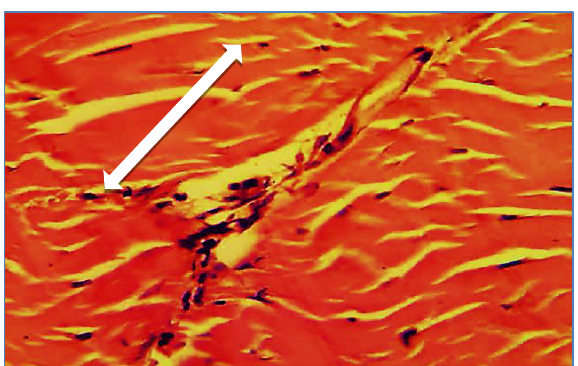
Figure, 10: In second group, 4 months post-implantation shows normal structure of tendon with few MNCs in epitenon (arrow) (H &E stain;